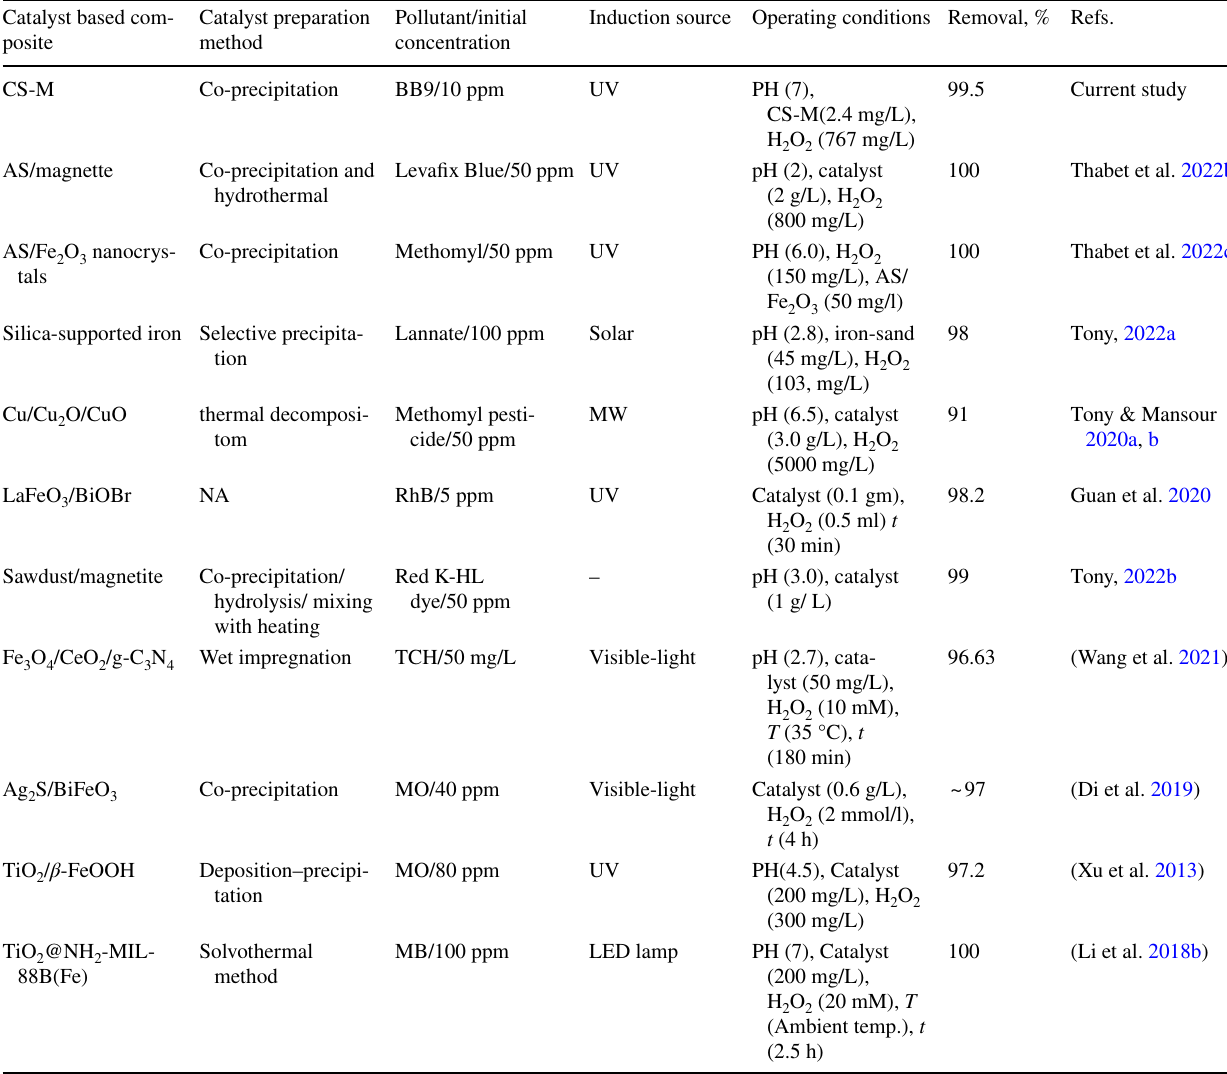
Table 6 Comparison of the current study with the various treatment systems from the literature through composite-based Fenton systems